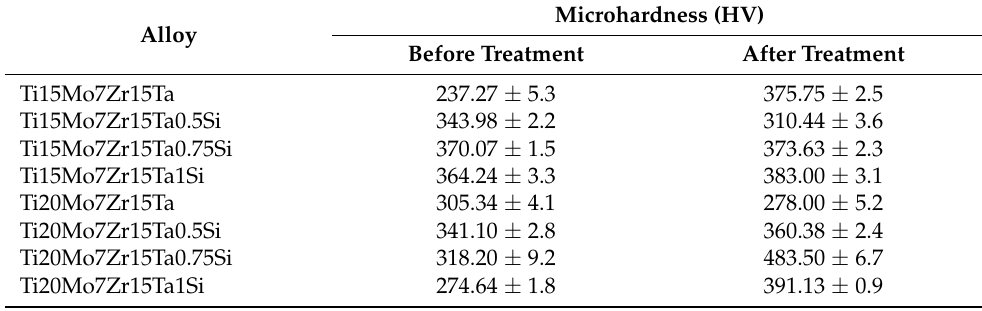
Table 4. Measured microhardness before and after the thermal treatment.